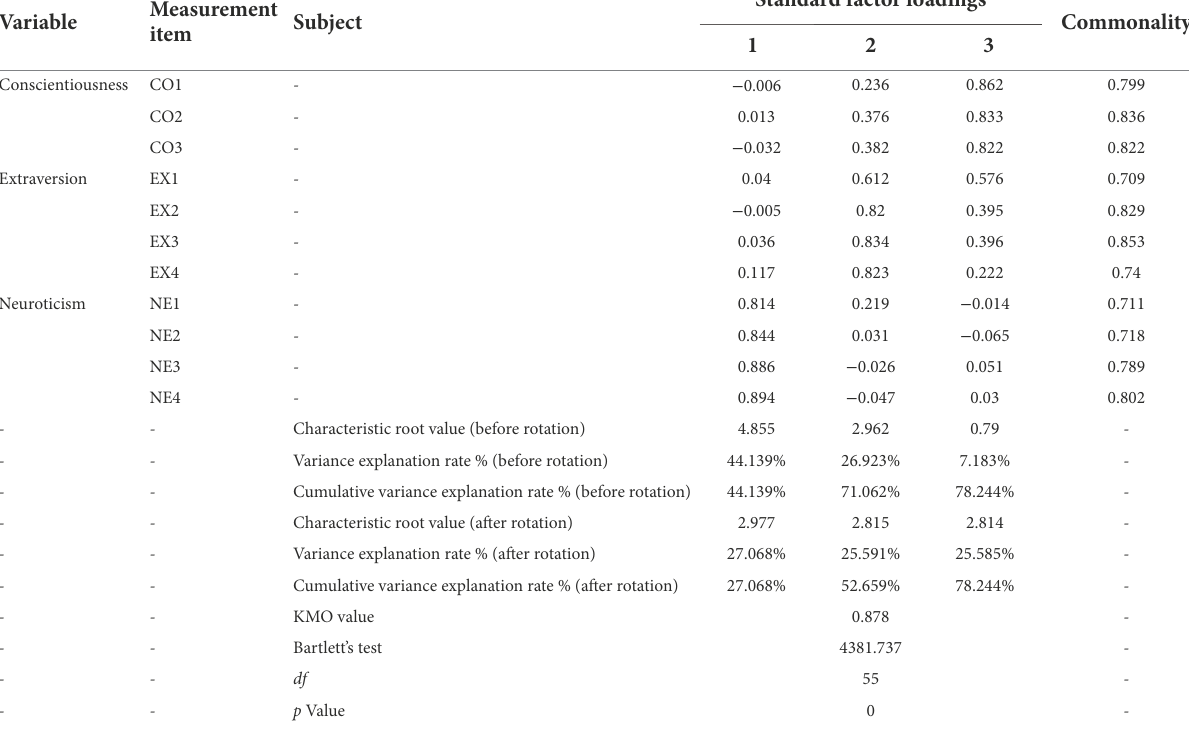
TABLE 5 Validity analysis indicators and results of personality trait scale.